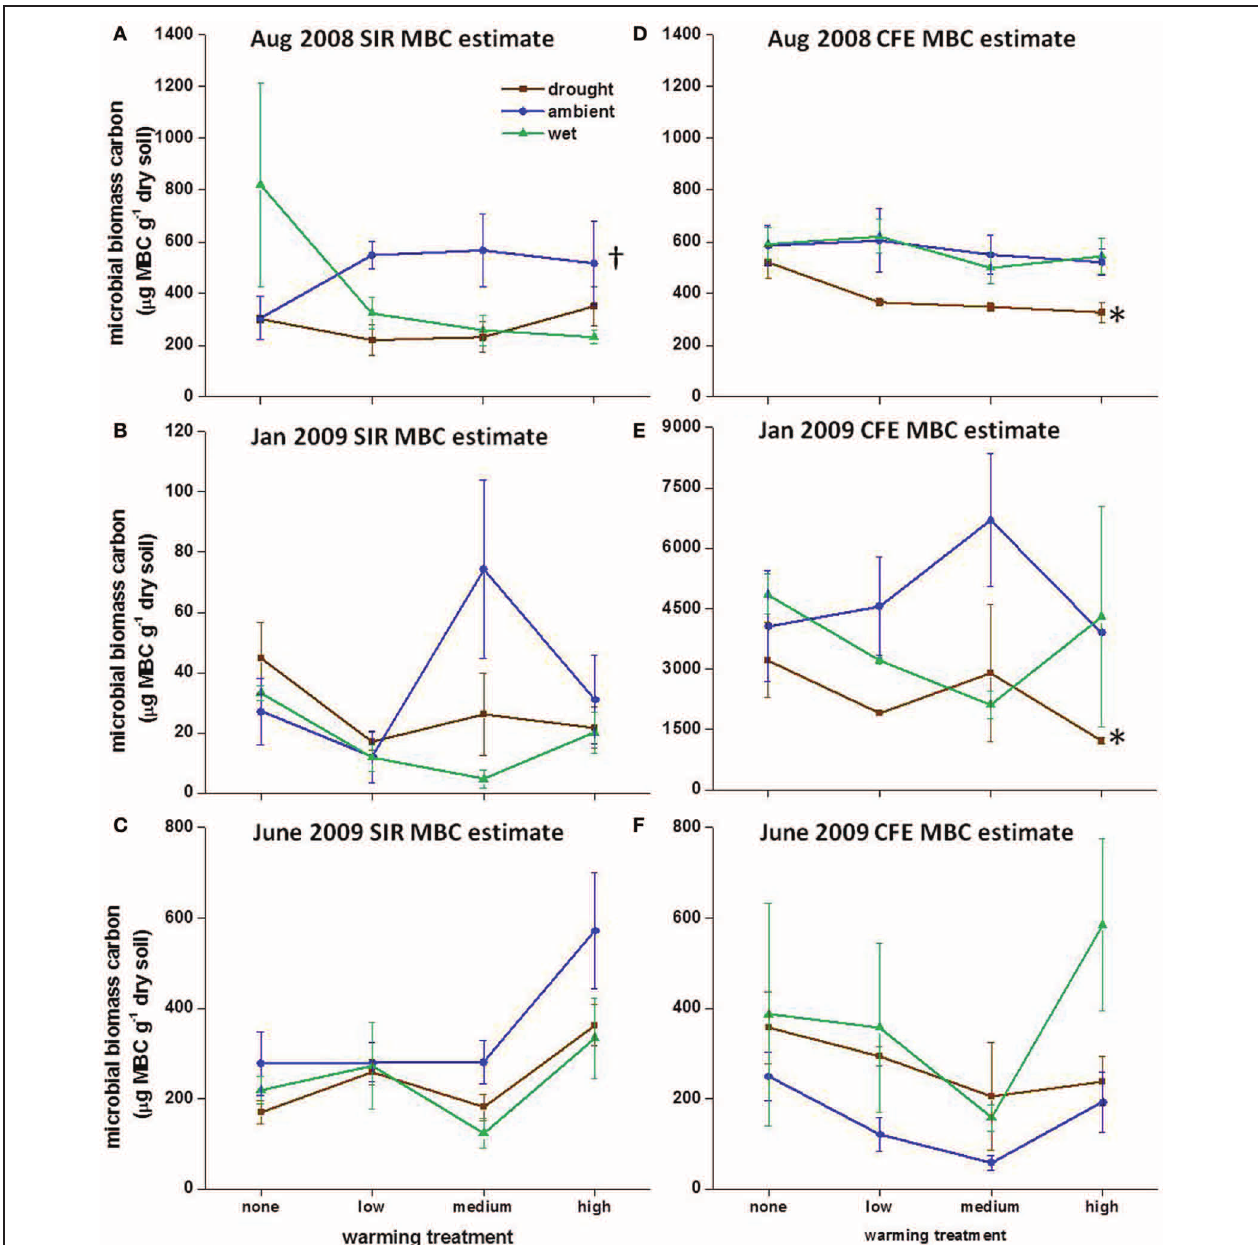
FIGURE 2 | Microbial biomass carbon (MBC) calculated using substrate-induced respiration (SIR) in (A) August 2008, (B) January 2009, and (C) June 2009 and using chloroform fumigation extraction (CFE) in (D) August 2008, (E) January 2009, and (F) June 2009. Symbols show averages with standard error bars, n = 3.